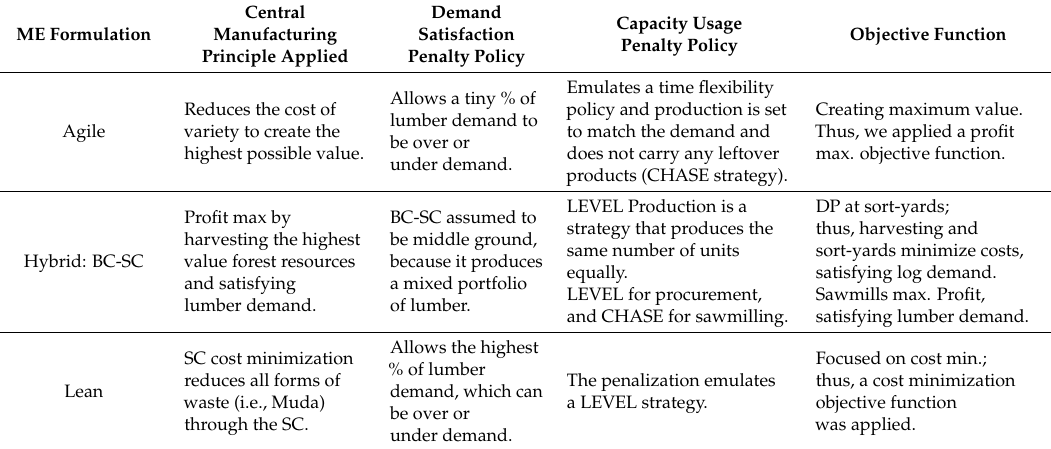
Table 2. Summary of manufacturing environment model formulations. ME: manufacturing